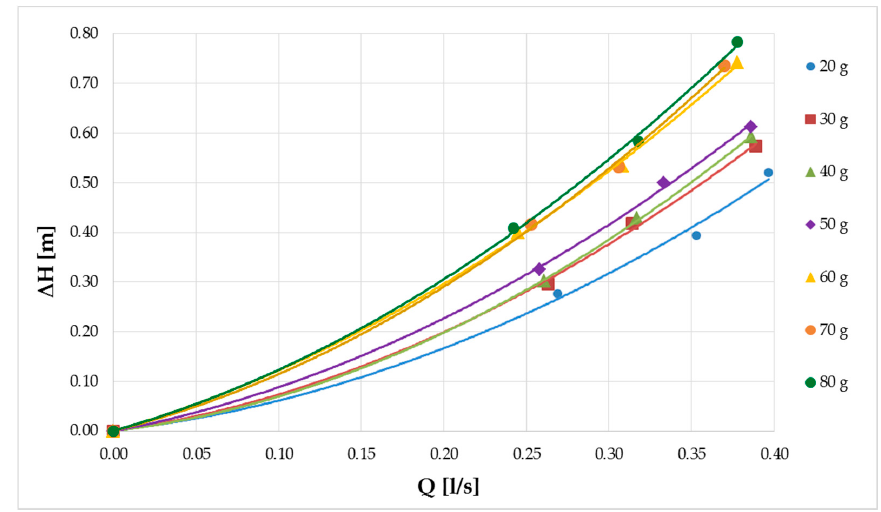
Figure 9. Results of all tests of clogging with fine sand in terms of head losses as functions of discharges for the three different discharges.